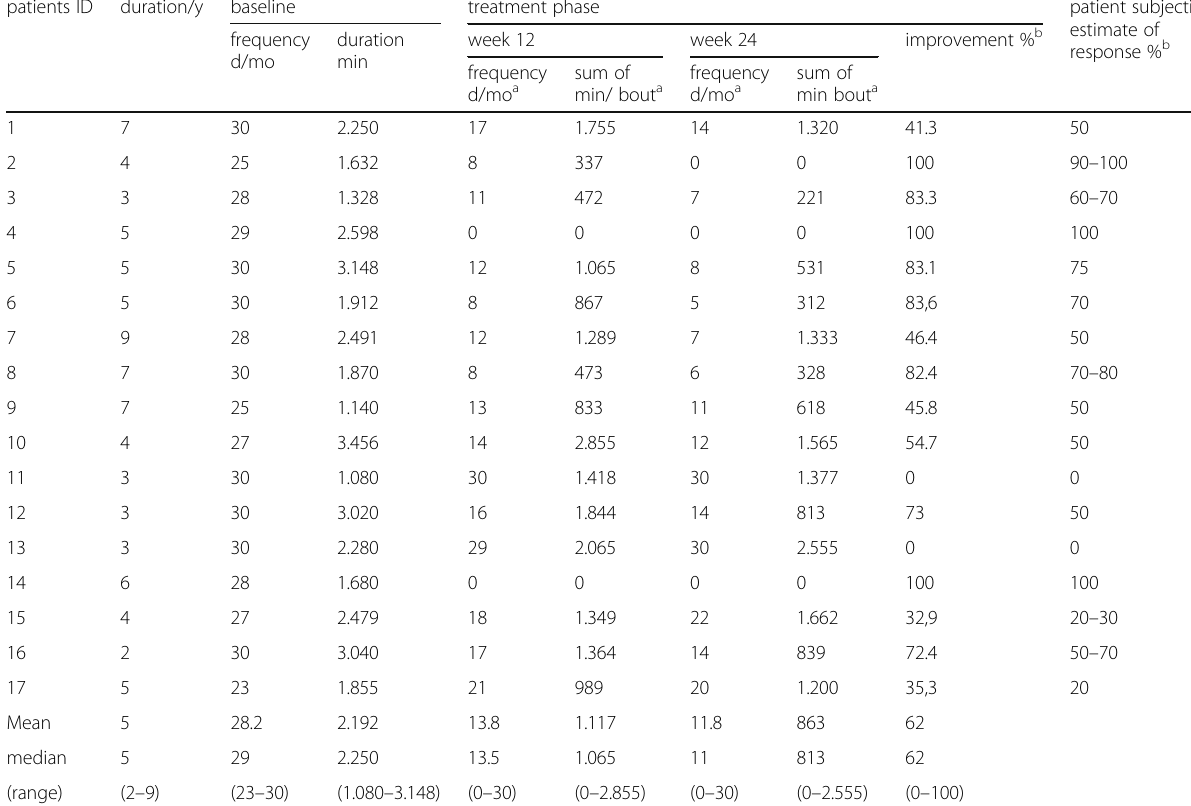
Table 2 Demographic details, headache scores pre- and post- treatment with OnabotulinumtoxinA patients